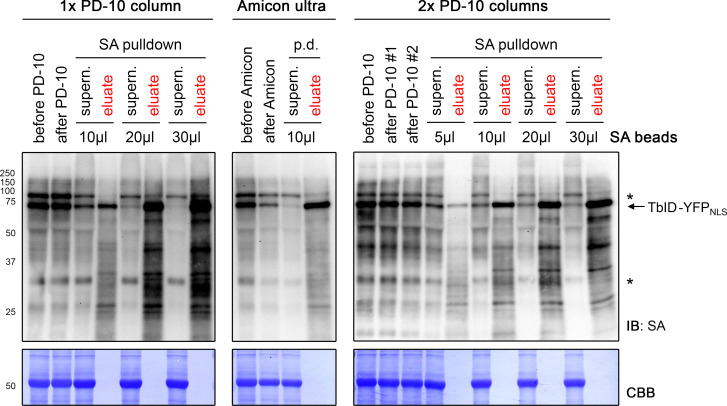
Comparison of different biotin depletion methods and bead concentrations for an effective pulldown of biotinylated proteins.Five-day-old seedlings expressing the UBQ10pro::TbID-YFPNLS construct were submerged in a 50 μM biotin solution for 3 h and used for biotin depletion-affinity purification (AP) experiments. For biotin depletion, protein extracts were either filtered through one (1x) or two consecutive (2x) PD-10 desalting columns or concentrated repeatedly using an Amicon Ultra centrifugal filter. Samples were taken before and after this step to check for protein loss. From the biotin-depleted extracts, a volume corresponding to 1/5 of the amount used for the PL experiments shown in Figures 4–6 was used for AP with the indicated amount of streptavidin (SA) beads. Samples of the supernatants after AP and of the proteins eluted from the beads were taken to determine the ratio of biotinylated proteins remaining in the protein extract and bound to the beads. All samples were analyzed by immunoblotting (IB) with SA-HRP. The amount of protein extracts and bead eluates loaded correspond to 0.05% and 0.5% of the total volumes, respectively. The Coomassie Brilliant Blue-stained membranes (CBB) are shown as loading controls for the IBs. Asterisks mark the positions of naturally biotinylated proteins. Biotin depletion with the Amicon Ultra Centrifugal filter, but not with PD-10 columns resulted in considerable protein loss. Increasing the amount of beads increased the AP efficiency.